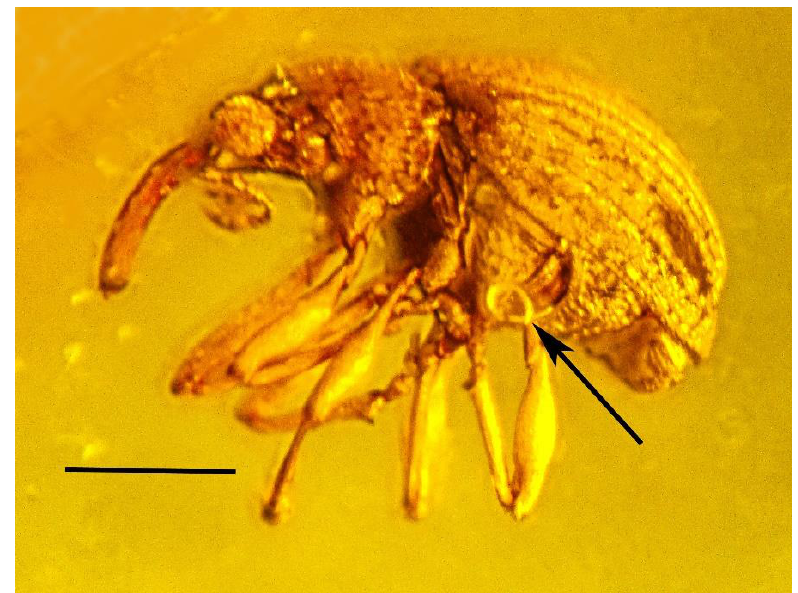
Figure 32. Parasitic nematode, Palaeoallantonema apionae (Nematoda: Allantonematidae) (arrow) that emerged from its apionid weevil host (Coleoptera: Brentidae) in Dominican amber. Scale bar = 420 µm.